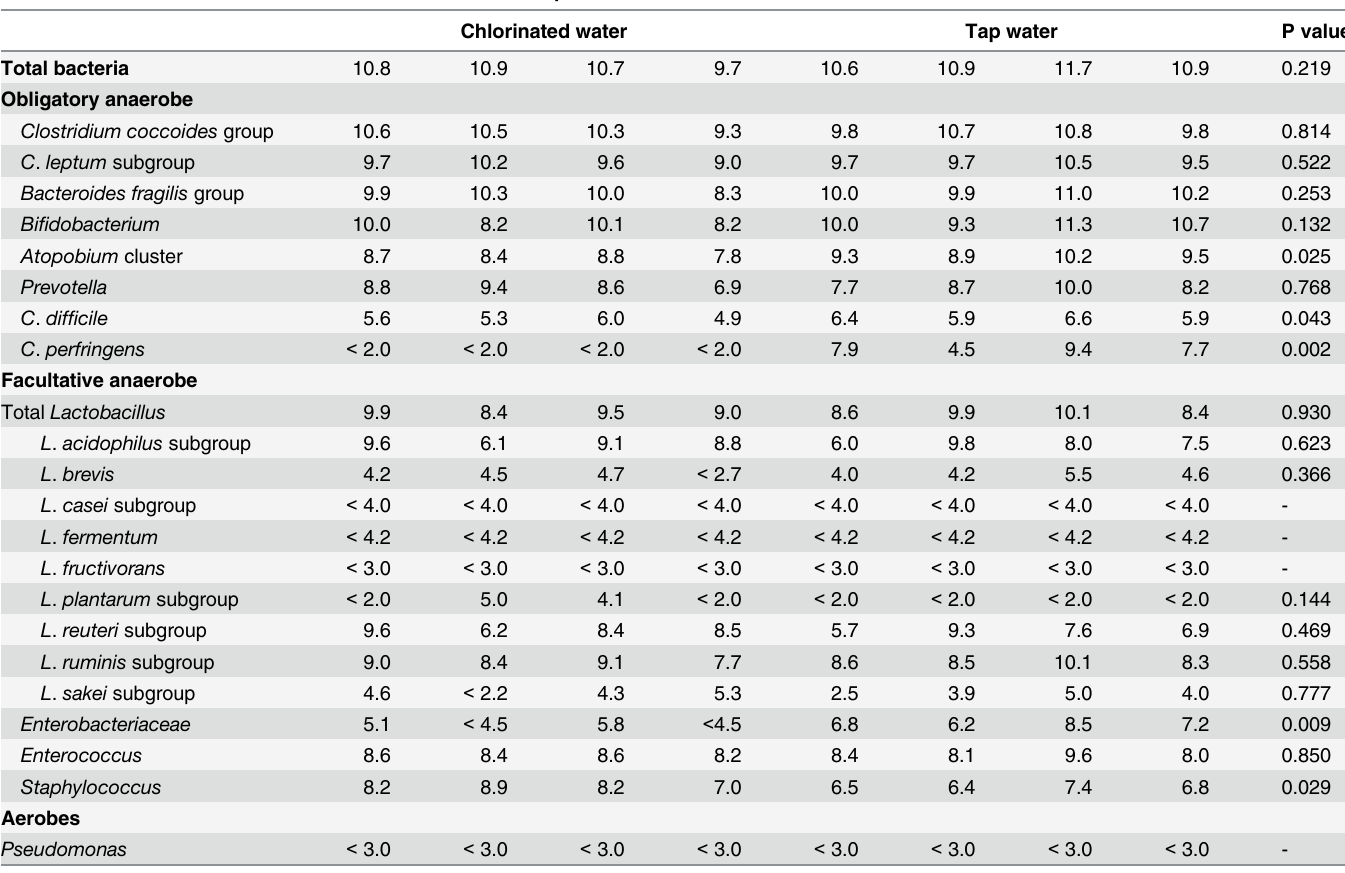
Table 1. Fecal bacteria in mice treated with chlorinated or tap water *